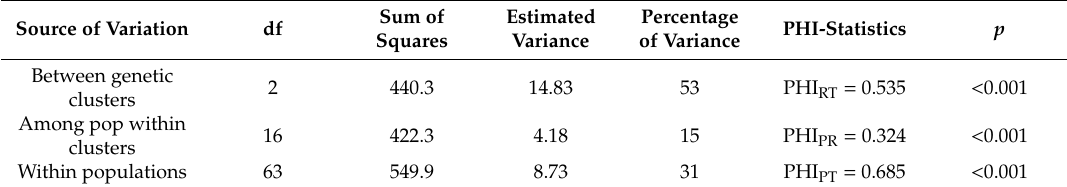
Table 3. Results of hierarchical AMOVA (analysis of molecular variance) based on the fingerprinting AFLP genotypes of 82 samples of true lavender. The significance level was set to p = 0.05.